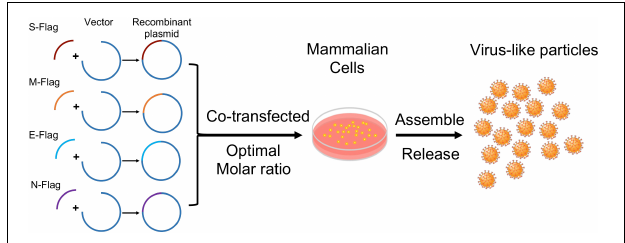
FIGURE 1 | Schematic outline of SARS-CoV-2 VLPs constructions in mammalian expression system.